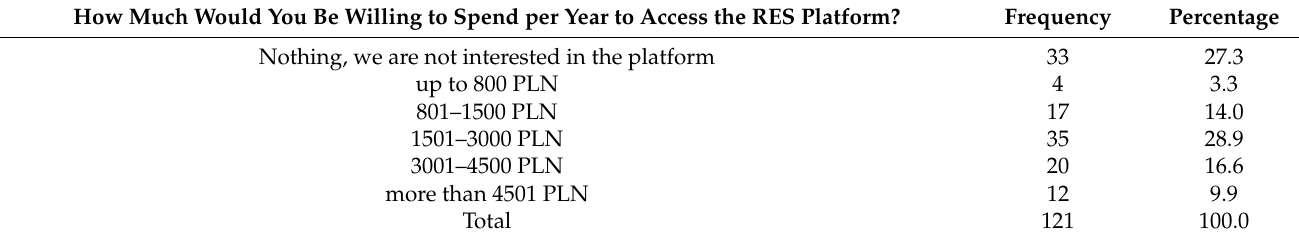
Table 11. The amount of expenditure that could be incurred by companies for access to the RES platform. How Much Would You Be Willing to Spend per Year to Access the RES